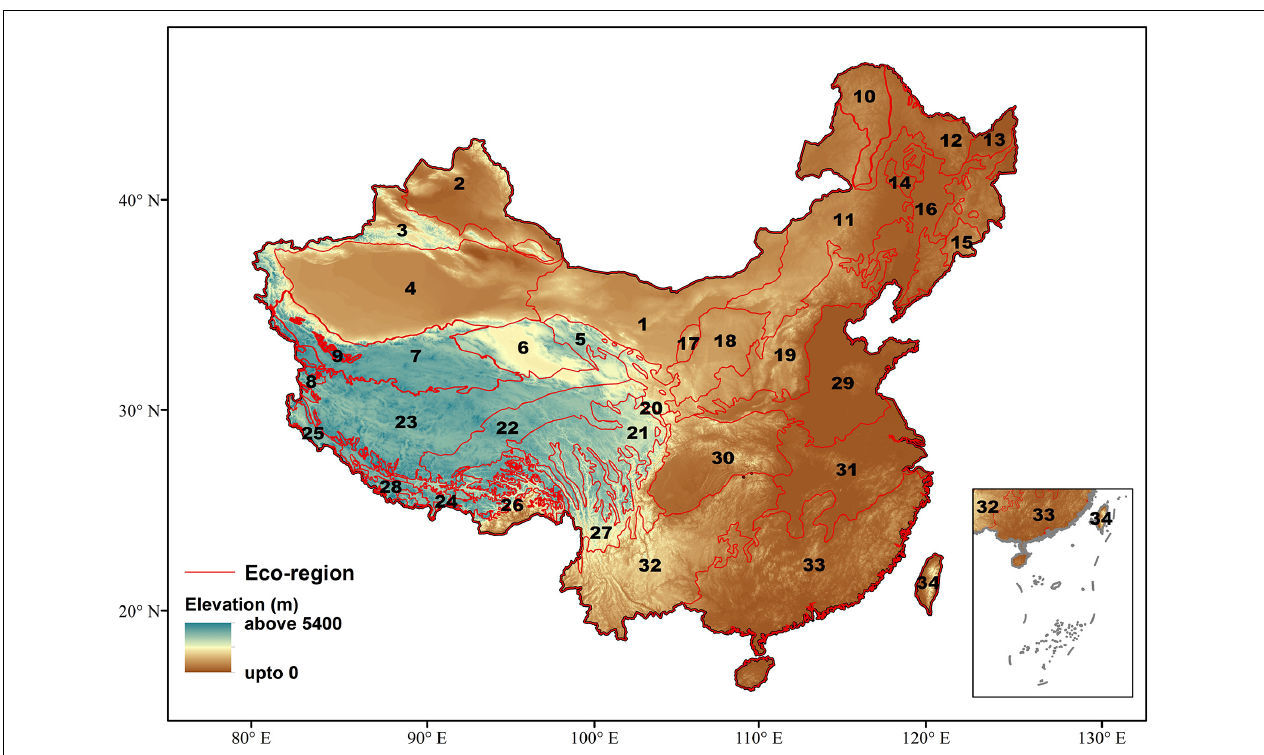
FIGURE 1 | Ecoregion of China and its elevation differentiation. The numbers in the map indicate the number of ecoregions used as a reference in this study. The differentiation of ecoregions is based on Olson and Dinerstein (2002). 1, Eastern Gobi desert; 2, Junggar basin; 3, Tian Shan Mountain; 4, Tarim basin; 5, Qilian Mountains; 6, Qaidam basin; 7, North Tibetan Plateau-Kunlun Mountains; 8, Karakoram-West Tibetan plateau; 9, Rock and Ice; 10, East Siberian; 11, Mongolian–Manchurian; 12, East–Manchurian; 13, Suiphun-Khanka; 14, Nenjiang river basin; 15, Changbai mountains; 16, Northeast China plain; 17, Helanshan; 18, Ordos plateau; 19, Central China-Loess plateau; 20, Qilian Mountains; 21, Southeast Tibet; 22, Tibetan plateau; 23, Central Tibetan plateau; 24, Yarlung Tsangpo; 25, Northwestern Himalayan; 26, Eastern Himalayan; 27, Qionglai mountain; 28, Eastern Himalayan; 29, Huang-He plain; 30, Qin Ling Mountains; 31, Changjiang plain; 32, Guizhou plateau; 33, South China; 34,